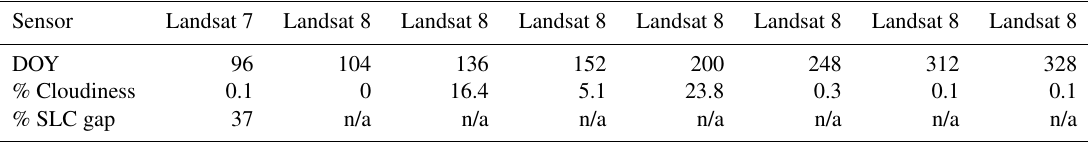
Figure 3. A Landsat 8 true color image (5 September 2013) showing the North Carolina study area. The yellow crosses indicate the location of the NC2 and NC3 flux towers. Table 1. Landsat overpass dates used in the